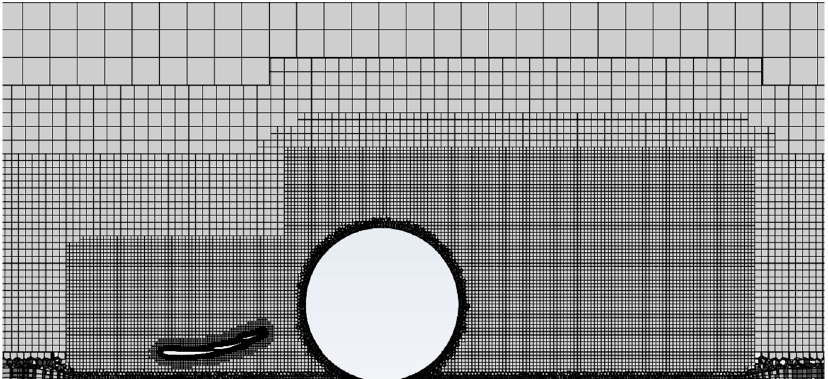
Figure 4. Side view of the grid for a plane cutting the wing and wheel.